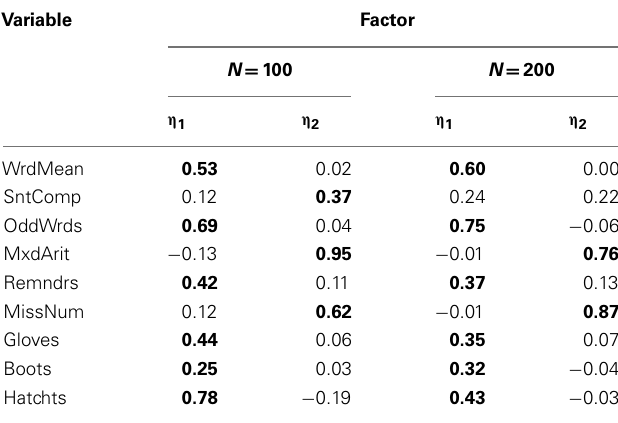
Table 12 |Two-factor model loading matrix obtained with EFA of product-moment R among Case 4 item-level